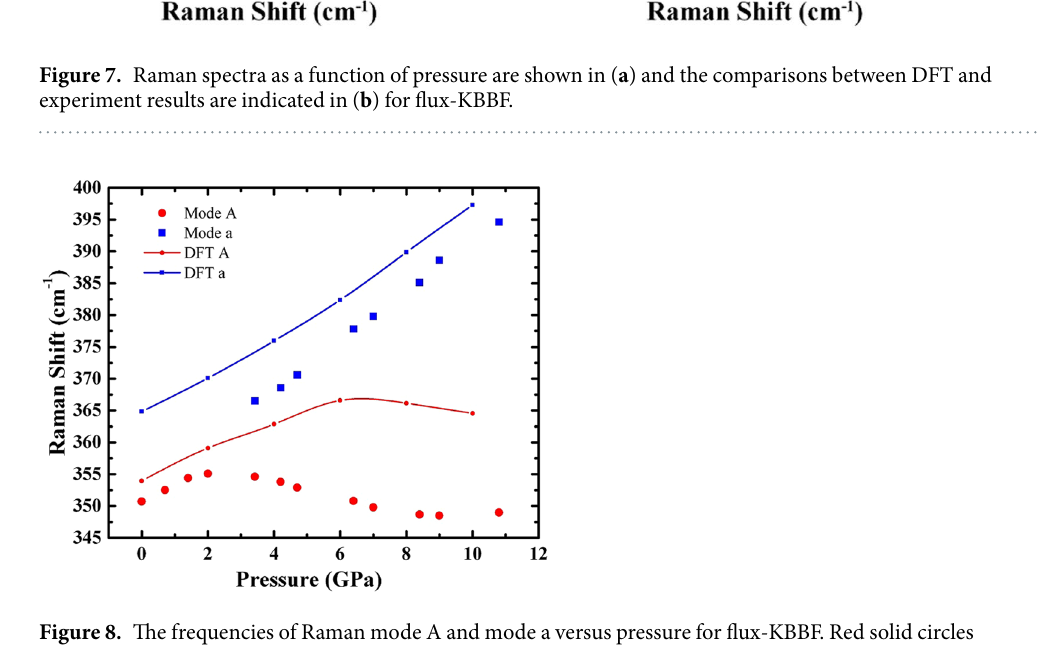
Figure 8. The frequencies of Raman mode A and mode a versus pressure for flux-KBBF. Red solid circles and blue solid squares represent experimental values, while the corresponding lines are the results from DFT